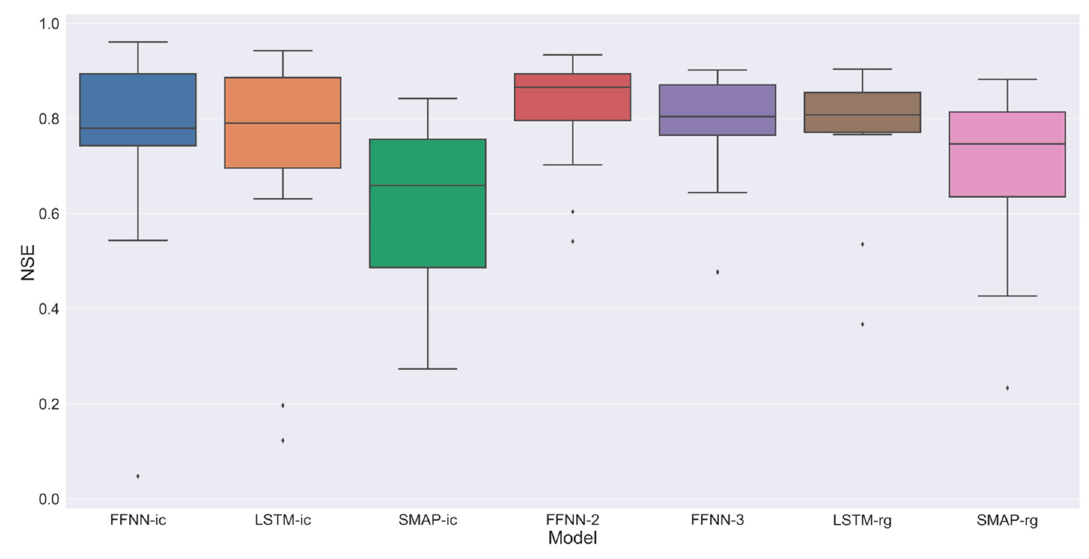
Figure 8. Boxplot comparing models’ performance.